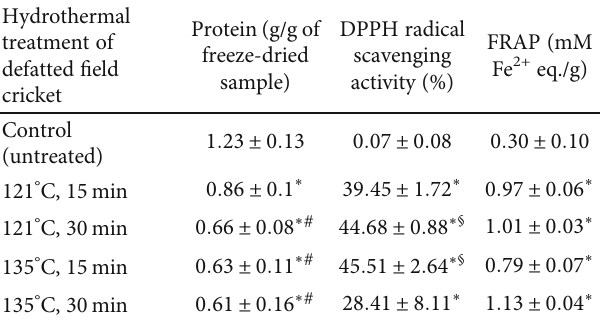
Table 4: Protein content, DPPH radical scavenging activity, and FRAP of defatted fi eld cricket before and after subcritical water